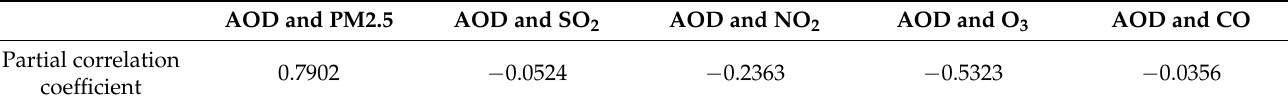
Figure 5. Seasonal variation trend of PM2.5, near-surface atmospheric trace gas concentration, and AOD during the study. AOD is dimensionless and plotted on the sub coordinate axis, the unit of CO concentration is (mg/m 3 )*100, and the others are μg/m 3 . Table 2. The partial correlation coefficient between AOD and PM2.5, SO 2 , NO 2 , O 3 , and CO. AOD and PM2.5 AOD and SO